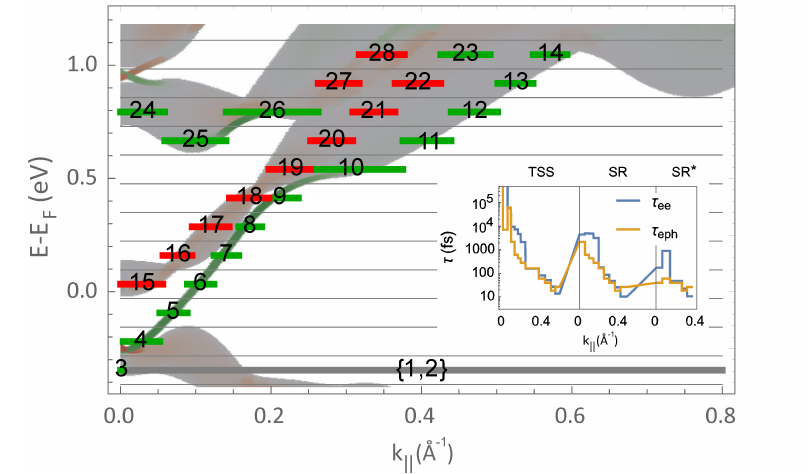
Figure 3. Electron bands used in the Boltzmann calculations compared to the GW band structure of Bi 2 Te 3 . The Boltzmann dynamics was solved numerically by discretizing the GW bands and their spin orientation. Red and green colors correspond to opposite spin states, and the spin orientations are locked to the electron momentum. Inset: electron–electron and electron–phonon scattering lifetimes, obtained by computing the k -dependent decay time of a small excitation above the room temperature Fermi–Dirac occupation. The horizontal axis is split along the electron wave vector parallel to the surface, and follows the calculated energy-momentum dispersions of individual bands, labeled TSS, SR and